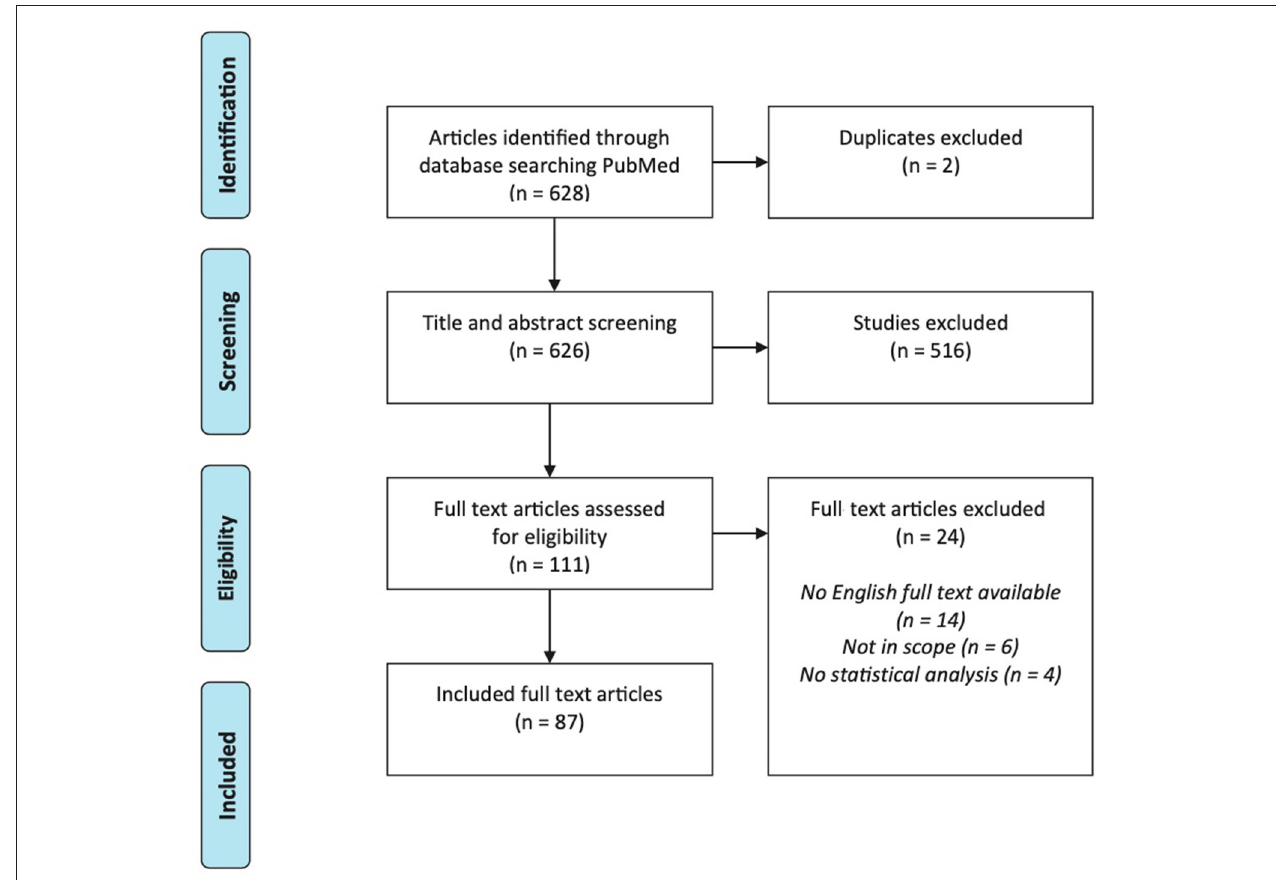
FIGURE 1 | PRISMA flow diagram representing the search and screening process.